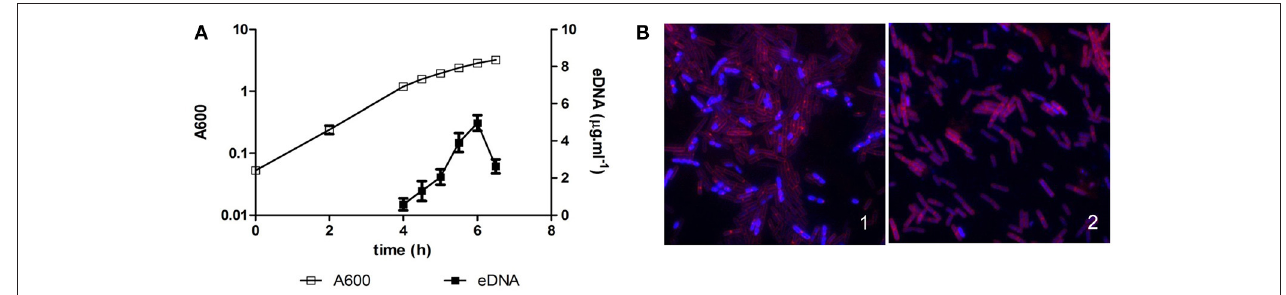
FIGURE 3 | eDNA production in Bacillus subtilis 3610. (A) Batch culture of strain 3610 in MSgg at 37 ◦ C with aeration. A600 refers to the absorbance of the culture at 600 nm, and eDNA refers to the concentration of eDNA in the culture supernatant. eDNA is released during the transition from exponential to stationary phase, followed by a rapid decrease in eDNA concentration. The data presented are representative of the results obtained in ten different experiments. (B) fluorescent microscopy image of cells from a wild type 3610 strain (1) and an eDNA defective mutant (2) after 5 h 30 min in batch growth. The DNA is stained blue (DAPI) and cellular membranes are stained red (FM4.64). A subpopulation of cells has a greater intensity of DNA staining in a wild type strain but not in a defective mutant in eDNA production.